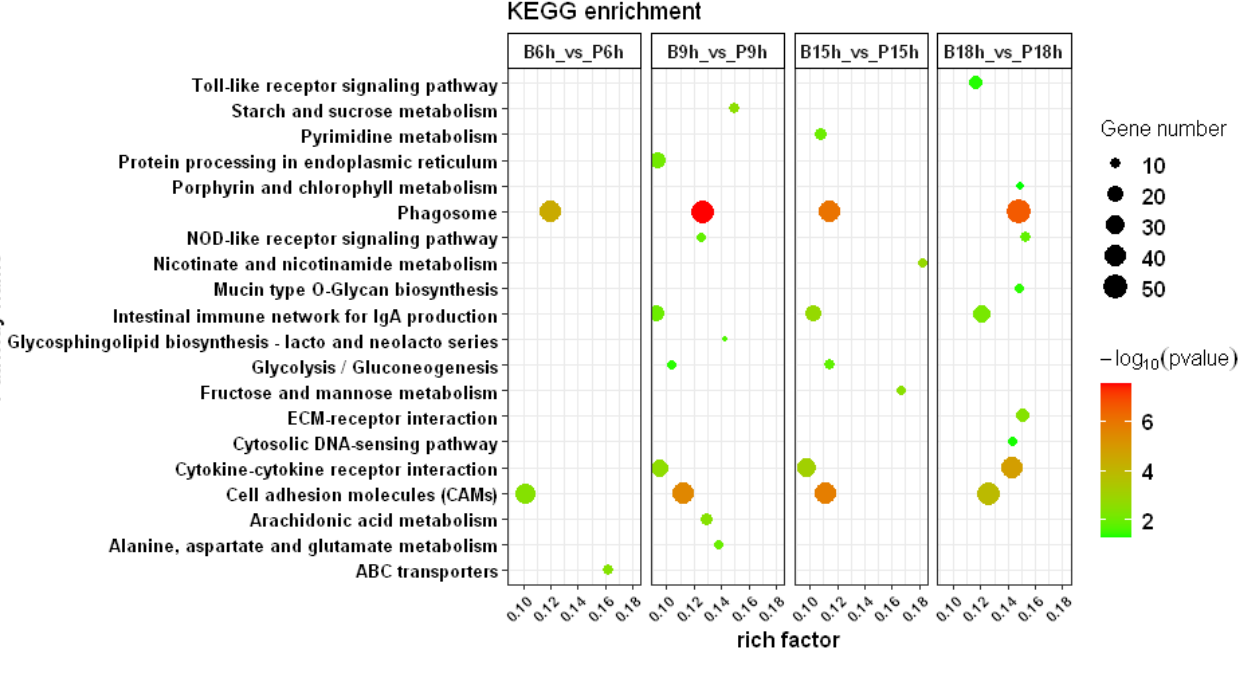
Figure 4. KEGG enrichment analysis scatter plot representing pathways of significant DEGs between GBS and PBS groups in four comparisons. Red color indicates highly significant GBS and PBS groups in four comparisons. Red color indicates highly significant enrichment according enrichment according to the p -value range. to the p -value